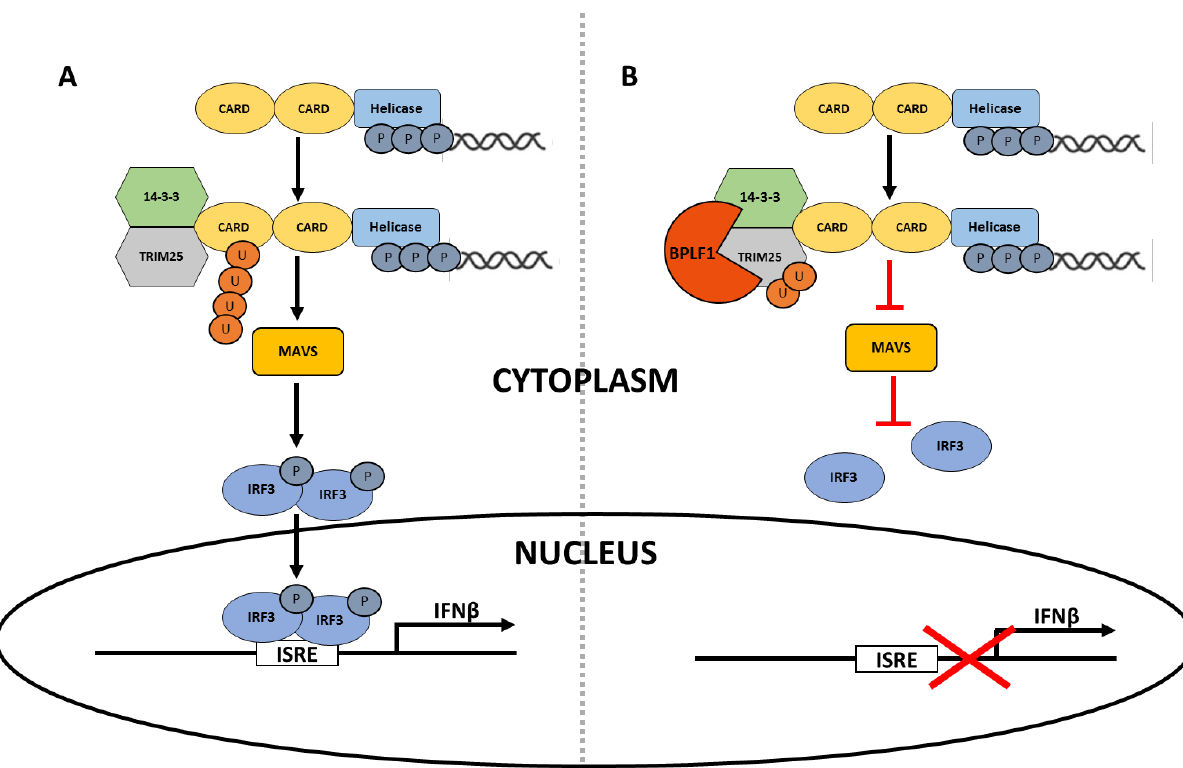
FIGURE 1: Proposed model for inhibition of the RIG-I signalosome by herpesvirus deconjugases. (A) Following binding to nucleic acids RIG-I undergoes a conformational change that exposes the CARD domains. Activated RIG-I binds to TRIM25, which promotes ubiquitination of the first CARD domain. 14-3-3 stabilizes the RIG-I-TRIM25 complex and promotes its translocation to MAVS where subsequent ubiquitin- regulated events lead to phosphorylation of the IRF3 transcription factor (p-IRF3). Activated IRF3 is translocated to the nucleus where it binds to IFN-response element (ISRE) leading to the activation of type I IFN response. Activation events are indicated by black arrows. (B) BPLF1 and the homologs encoded by other herpesviruses form a tri-molecular complex with 14-3-3 and TRIM25, which leads to activation and autoubiquitination of the ligases. A yet uncharacterized sequence of events results in failure to ubiquitinate RIG-I and functional inac- tivation of the RIG-I signalosome. Inhibitory events are indicated by red inverted